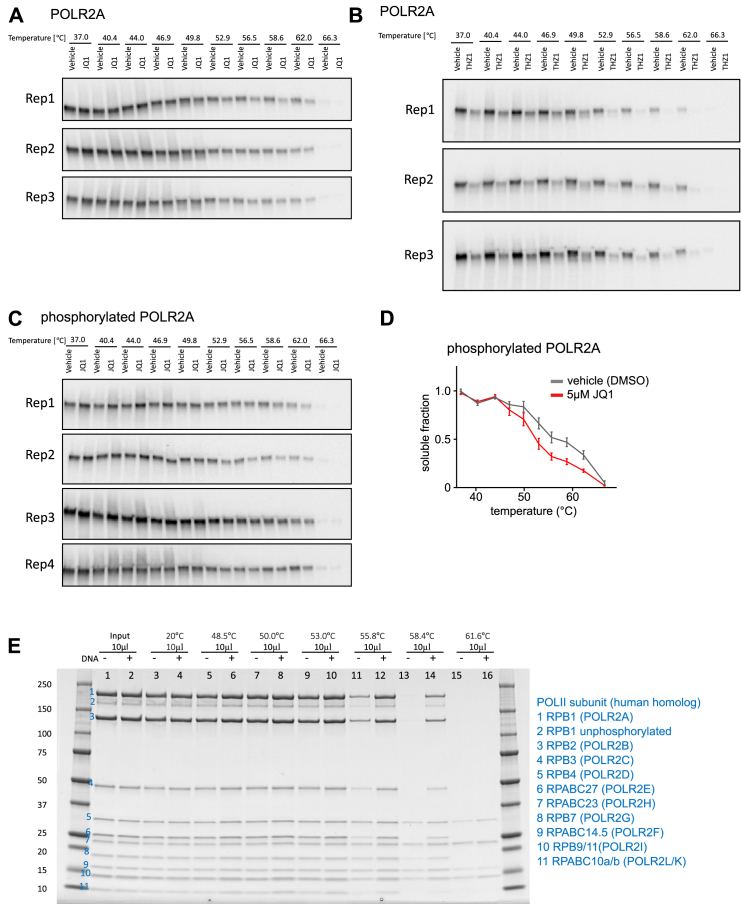
Related to Figure 4(A) Western blot images used for quantification of POLR2A destabilization upon 3h treatment with JQ1.(B) Western blot images used for quantification of POLR2A destabilization upon 3h treatment with THZ1, as well as melting curve plot derived from this image.(C) Western blot images used for quantification of phosphorylated POLR2A destabilization upon 3h treatment with JQ1.(D) Quantification of (C). SEM is shown.(E) Coomassie gel showing purified RNA Pol II complex from yeast. From left to right with increasing temperature, always control and treatment (+DNA) next to each other. Blue numbers indicate the subunits separated on the gel.